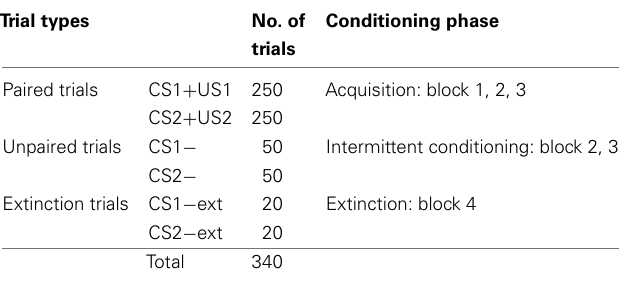
Table 1 | Different trial types in the conditioning paradigm of Exp